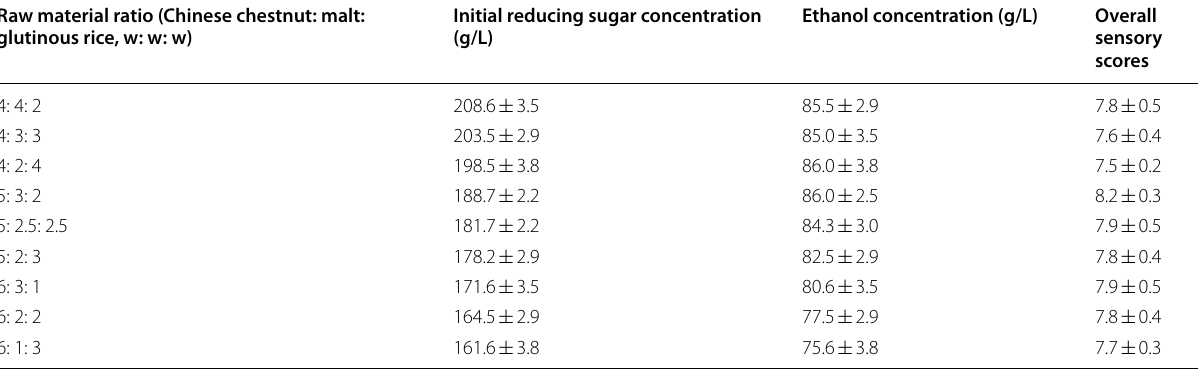
Table 5 Effect of different ratios of raw material on production of Chinese chestnut wine after 6 days of co-culture fermentation